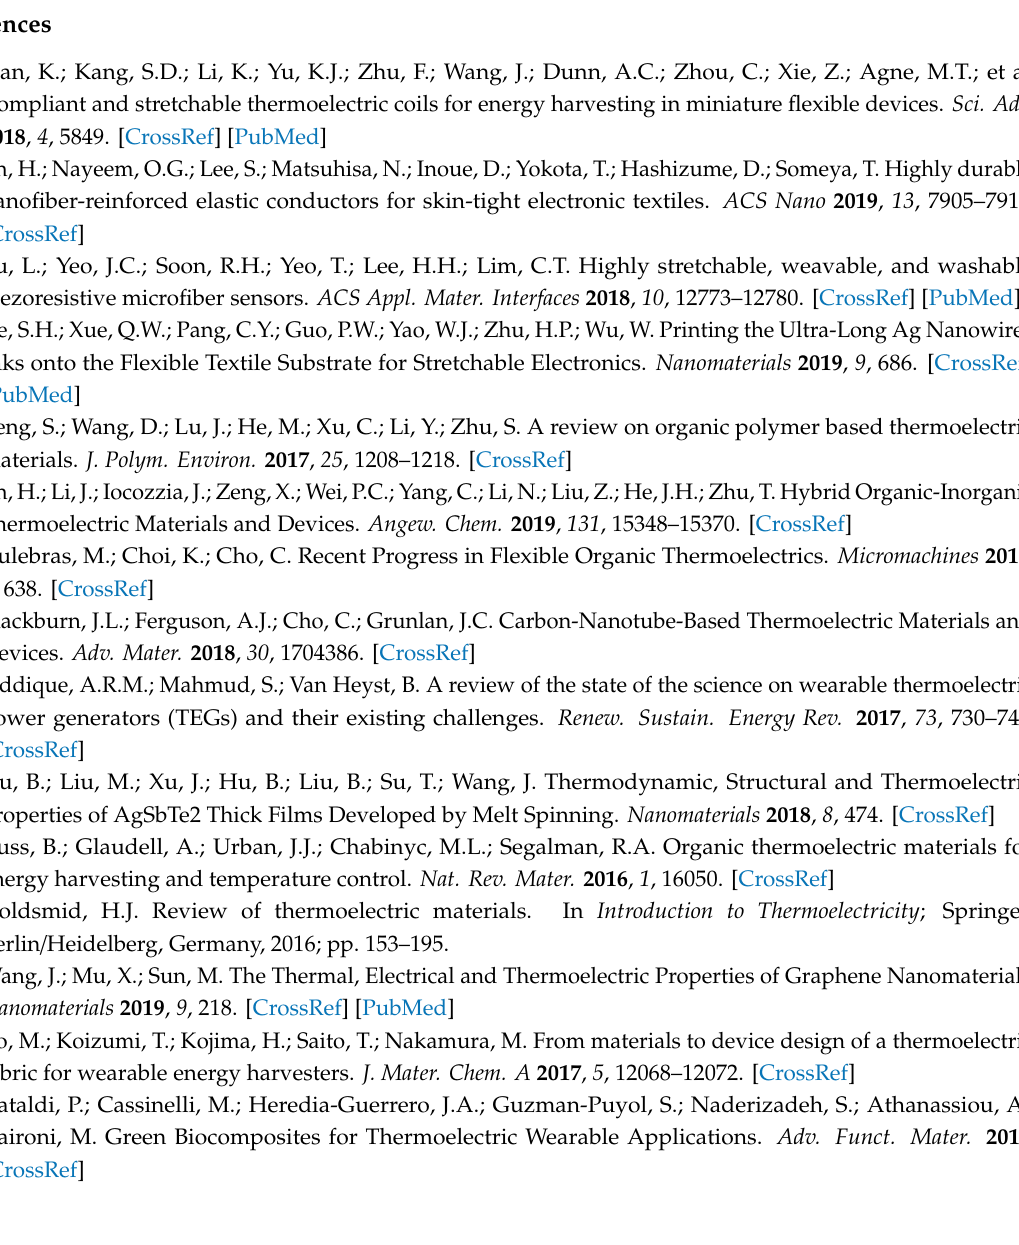
Figure S1: ( a ) Thickness and ( b ) mass of PEO / DWNT-PAA bilayer systems with di ff erent concentrations of PAA (0.1 and 0.2 wt%) as a function of deposition cycles. Figure S2: Electrical conductivity of PEO / DWNT-PAA assembled with 0.1 (filled square) and 0.2 (open square) wt% as a function of bilayers deposited. Figure S3: Schematics of carrier transport across the nanotubes in the PEO / DWNT-PAA nanocomposites where DWNT is dispersed with 0.1 and 0.2 wt% PAA, respectively. Figure S4: Normalized Seebeck coe ffi cient of ~500 nm thick 25 BL of PEO / DWNT-PAA in cyclic ( a ) bending and ( b ) twisting tests. Figure S5: Elastic modulus of 25 PEO / PAA BL and PEO / DWNT-PAA BL films deposited on a